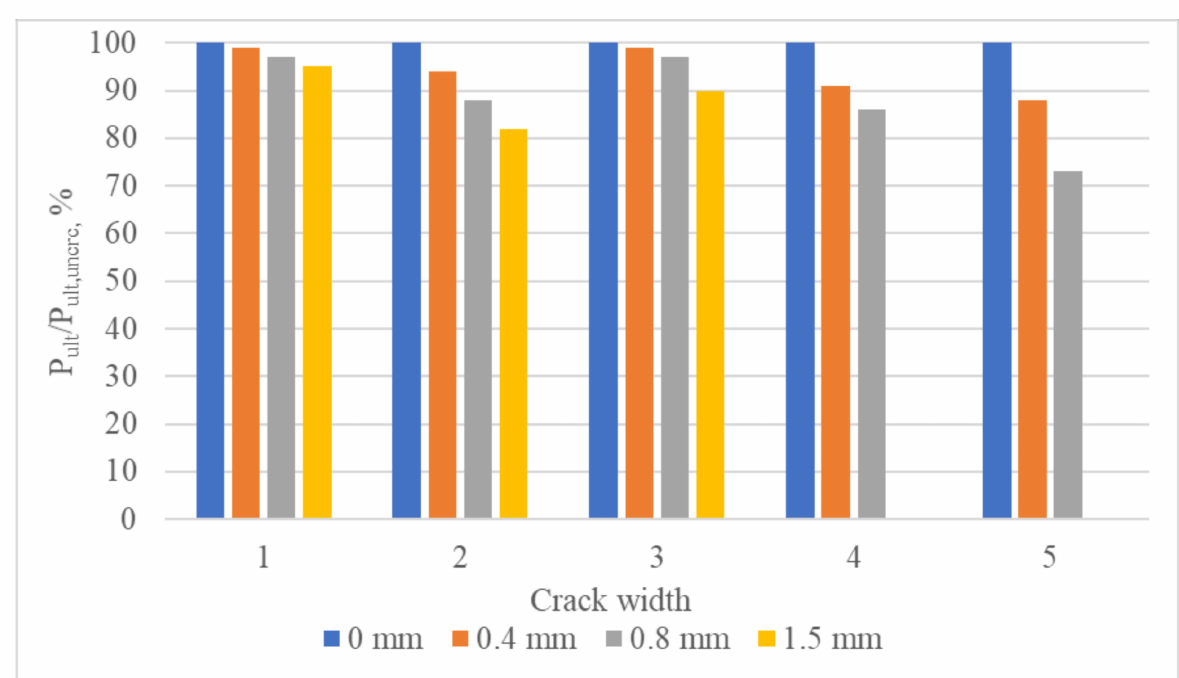
Figure 9. Reduction in the bearing capacity of an anchorage subjected to axial tensile loading depending on the crack opening width in the base: 1—cast-in-place anchors in case of steel failure; 2—cast-in-place anchors in case of concrete failure; 3—mechanical undercut anchors; 4—mechanical expansion anchors; 5—adhesive